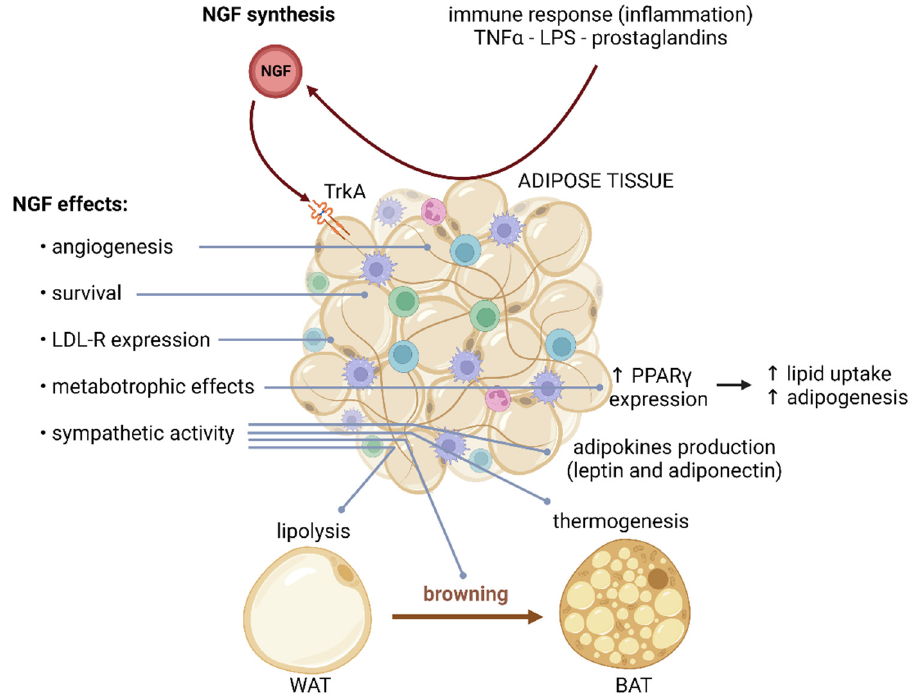
Figure 3. NGF effects on adipose tissue. Adipose tissue expresses NGF and NGF receptors. In adipocytes, proinflammatory factors induce an increase in NGF synthesis. TrkA signaling in adipose tissue favors angiogenesis and survival and has metabotropic effects. Through sympathetic innervation, NGF induces lipolysis in WAT, thermogenesis in BAT, and browning. Created with BioRen- der.com.